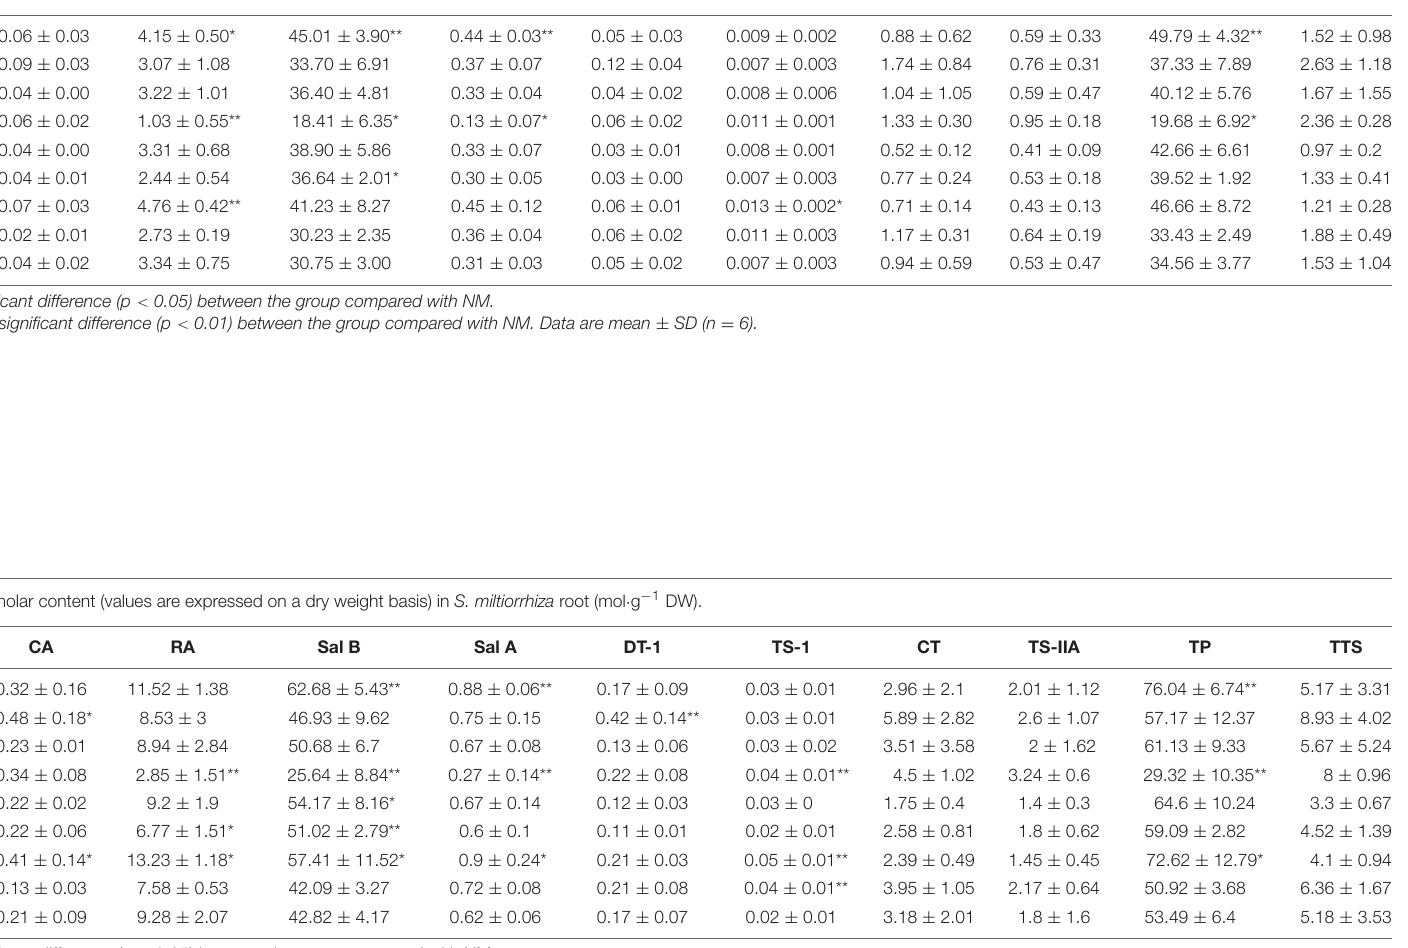
TABLE 3 | Active ingredients concentration (values are expressed on a dry weight basis) rate in S. miltiorrhiza root (mg · g − 1 DW). Sp.